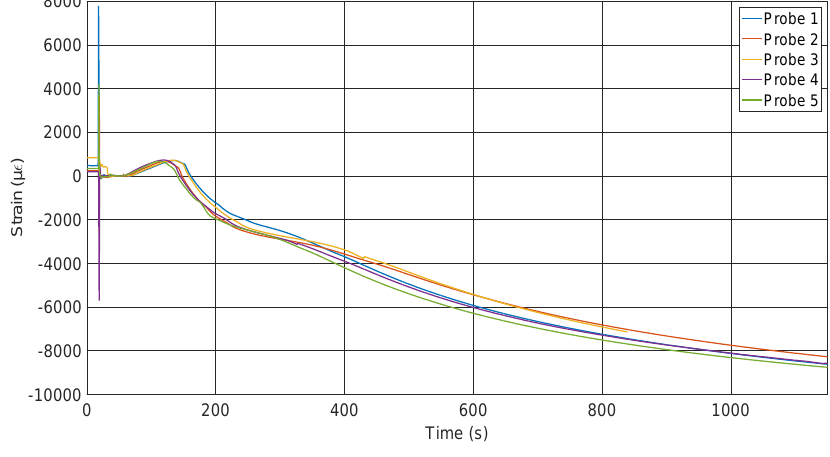
Figure 11. Strain along the fibre with offset.